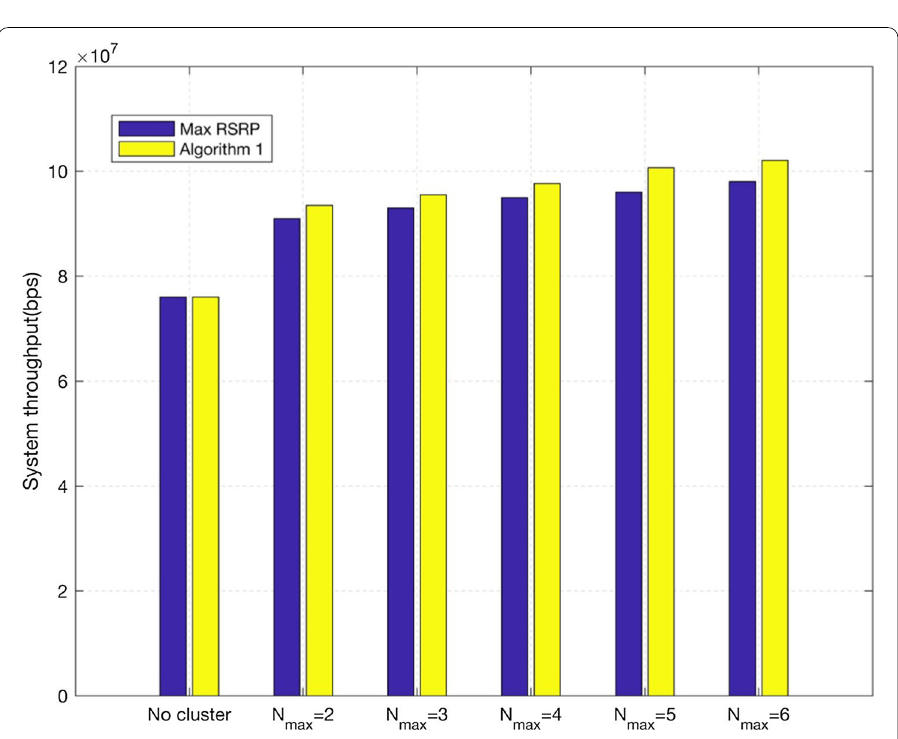
Fig. 10 Comparison of the system throughput for Max RSRP and Algorithm 1 user association with 350 UE/ km 2 and 50 SBS/km